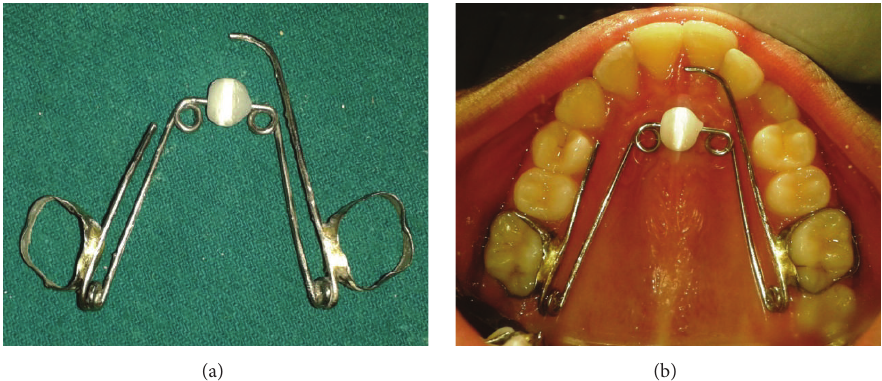
Figure 3: Design of modified quadhelix appliance with a roller. (a) Construction. (b) Insertion of the appliance.